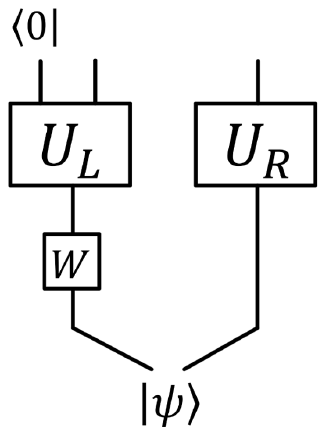
Figure 21. A model with two random unitaries, U L and U R , representing the two sides each with N qubits. | ψ i denotes a bulk state. M out of N qubits in the left side are projected to state | 0 i . W denotes an operator acting on the left bulk Hilbert